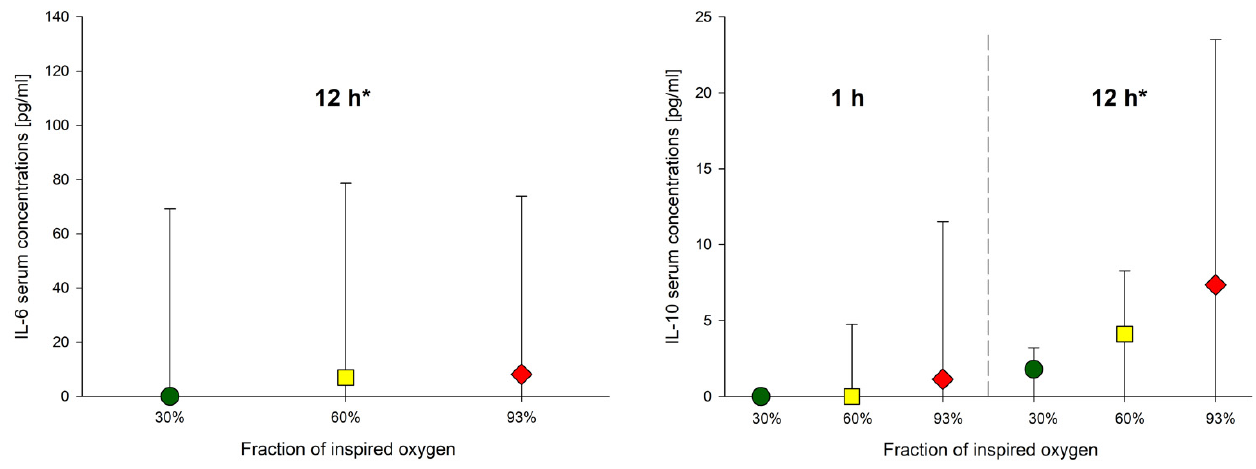
Figure 3. Cytokine serum concentrations. Data presented as medians and interquartile ranges. IL-6 at 1 h was 0 for all animals. IL-6 concentrations did not significantly differ by inspired oxygen ( p = 0.888), whereas IL-10 concentrations were significantly greater at 60% and 93% compared to 30% inspired oxygen (30% vs. 60%: p = 0.035; 30 vs. 93%: p = 0.001). Interleukin serum concentrations across all groups increased significantly between 1 and 12 h of mechanical ventilation (* IL-6: p = 0.002, * IL-10: p = 0.035).